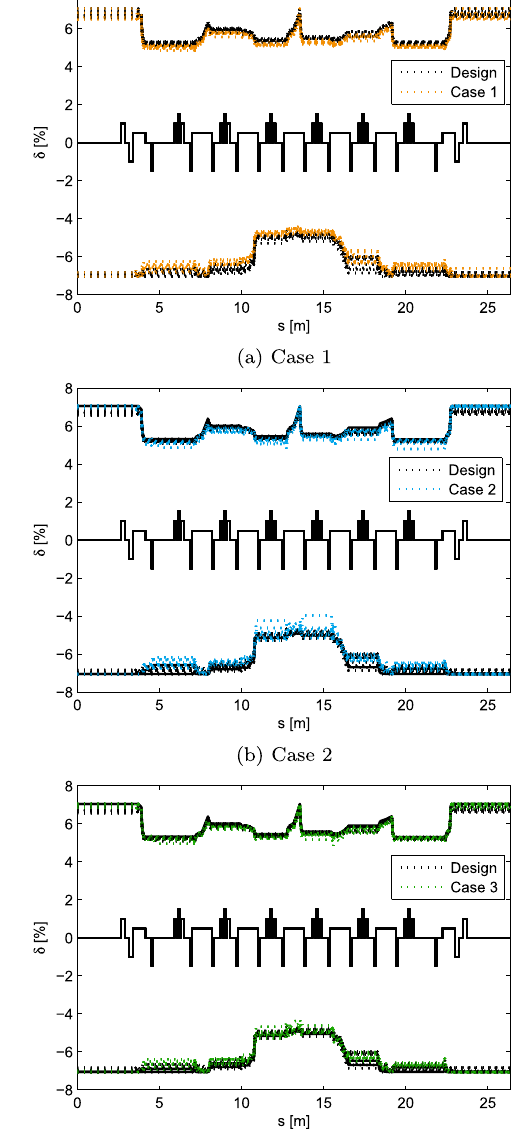
FIG. 12. Momentum aperture from 10 error seeds for the 3 cases, compared to design lattice (black) in the first